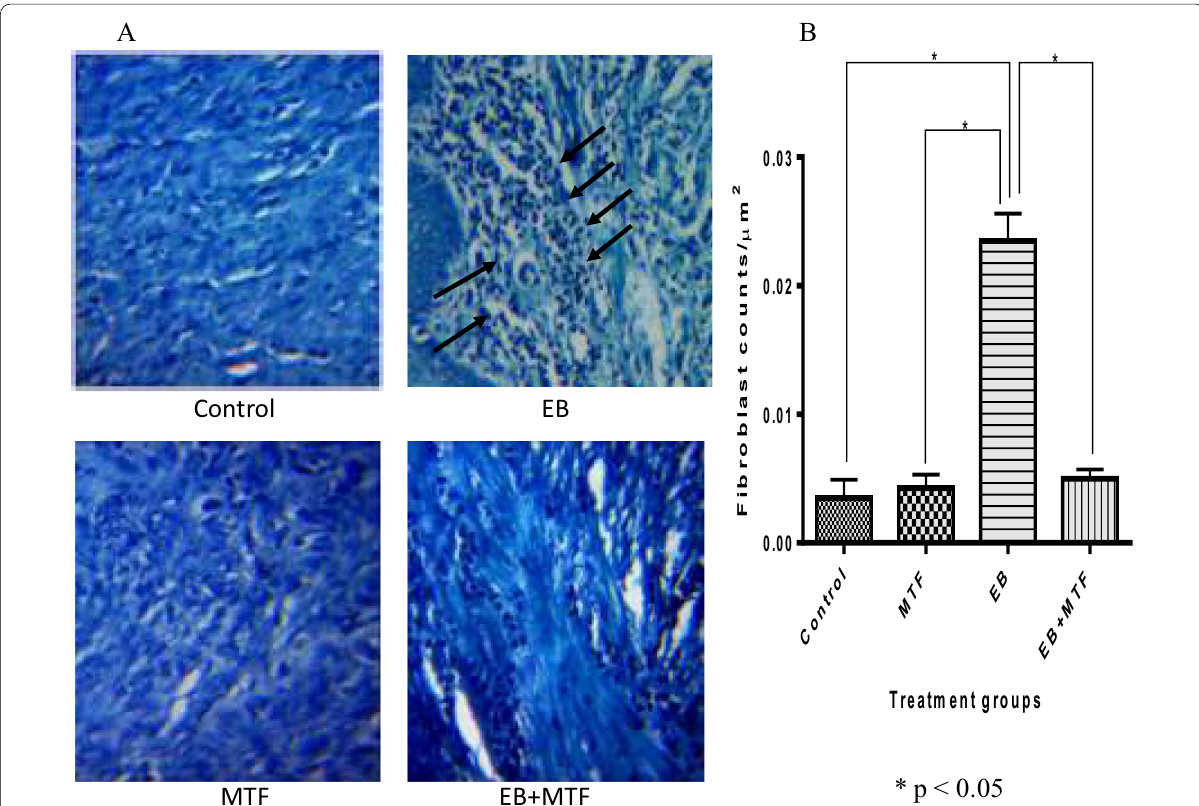
Fig. 6 Photomicrographs showing the effect of metformin on the myometrium of normal and EB-treated female rats using collagen Masson’s trichome stain ( a ) (Mag. X 400). Cell count density obtained from the myometrium of uterus of control and the EB-treated groups ( b ). Control and MTF: Plates show moderate deposition of collagen fiber. EB: Plates show high deposition of collagen fibers within the myometrium coupled with severe hyperplasia. EB MTF: Plates show reduction of collagen fiber within the myometrium and attenuation of the EB-induced uterine +